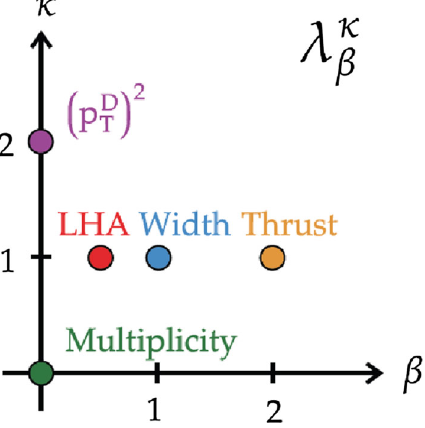
Fig. 38 Visualization of the space of the generalized angularities λ k β